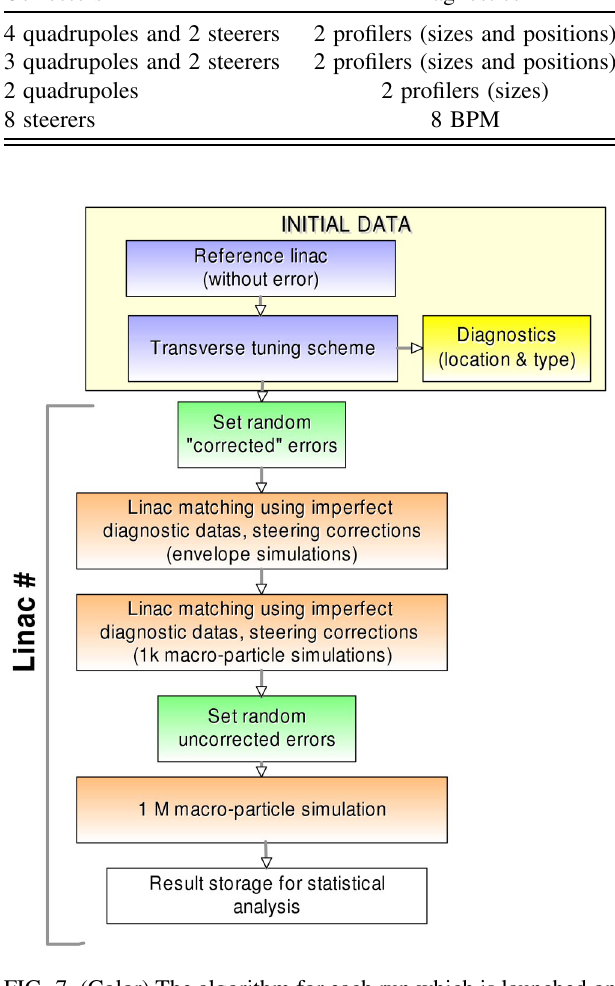
FIG. 7. (Color) The algorithm for each run which is launched on a node of the PC collection.